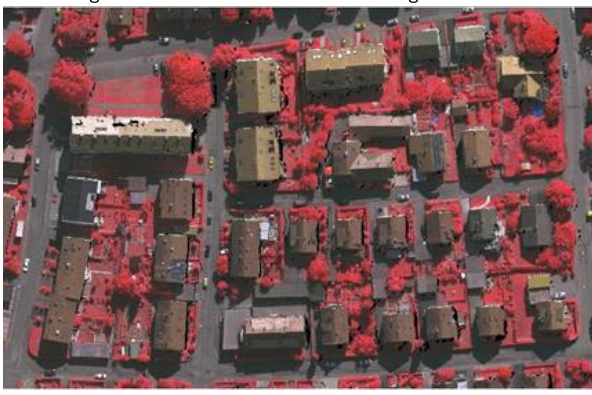
Figure 8. The orthoimage of the test site